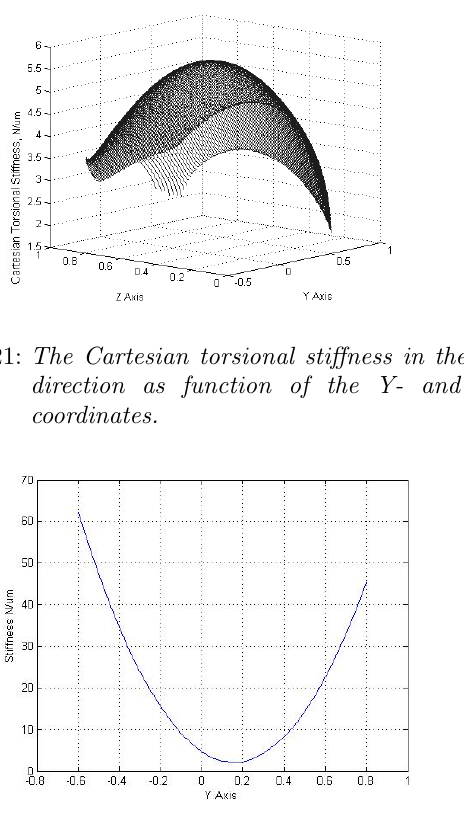
Figure 24: Cartesian stiffness in the Z-direction as function of the Y-coordinate at fixed X=1.0 and Z=0.3, 0.5,